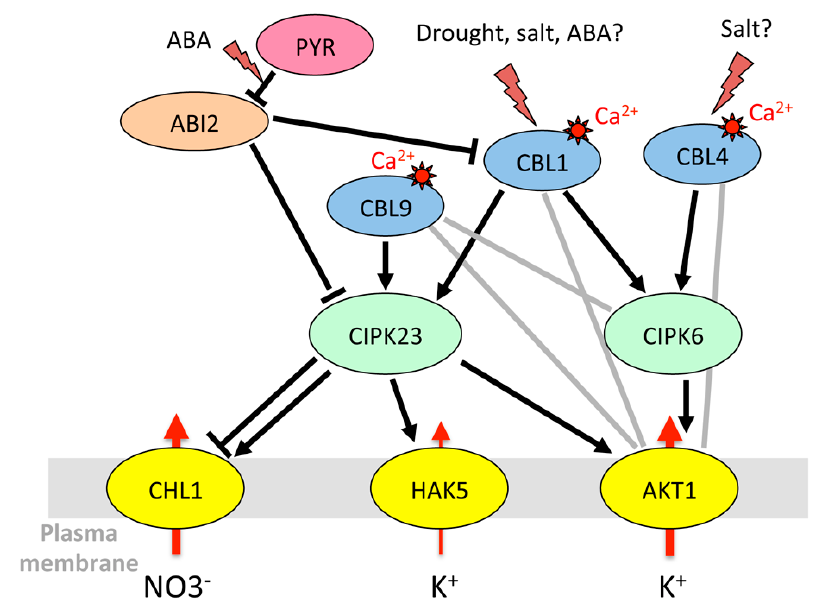
Figure 1. Model for cross-talks between CIPK (CBL-interacting protein kinase)/CBL (Calcineurin B-like protein) regulations of K + and NO3 − uptake by Arabidopsis roots, obtained by compilations of expression and interaction data. Positive and negative regulations are depicted in black (arrows and T-bars, respectively). Indications for physical interactions (two-hybrid, bimolecular fluorescence complementation (BiFC)) in the absence of further evidence for functional effect are represented by a gray line. Red arrows symbolize the ion fluxes. The lightning symbol is used when a stress or abscisic acid (ABA) results in a change in protein amount, protein activity or protein-protein interaction. The symbol “?” stresses that the effects of the treatments on CBL1 protein accumulation [162] were only addressed in whole leaves. Also, myristoylation of CBL4 is required for its function in